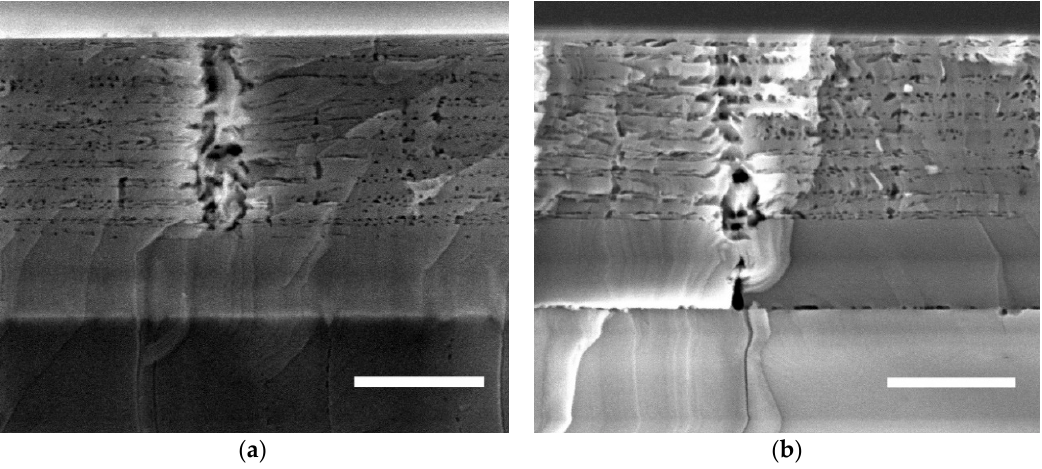
Figure 3. Cross-sectional scanning electron microscope (SEM) images of the porous structure of the AlGaN DBR. ( a ) Sample A, grown on an AlN template; and, ( b ) sample B grown on a GaN template. Scale bars are 500 nm.